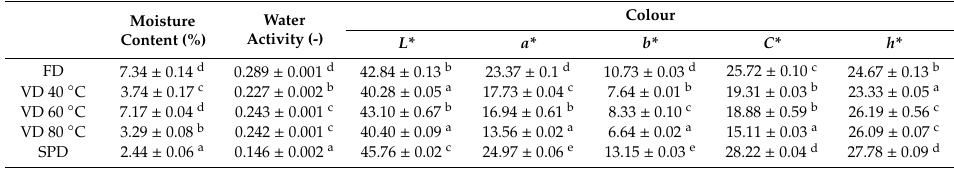
Table 1. Physical properties of the plum extracts powders (PEP) obtained after di ff erent drying